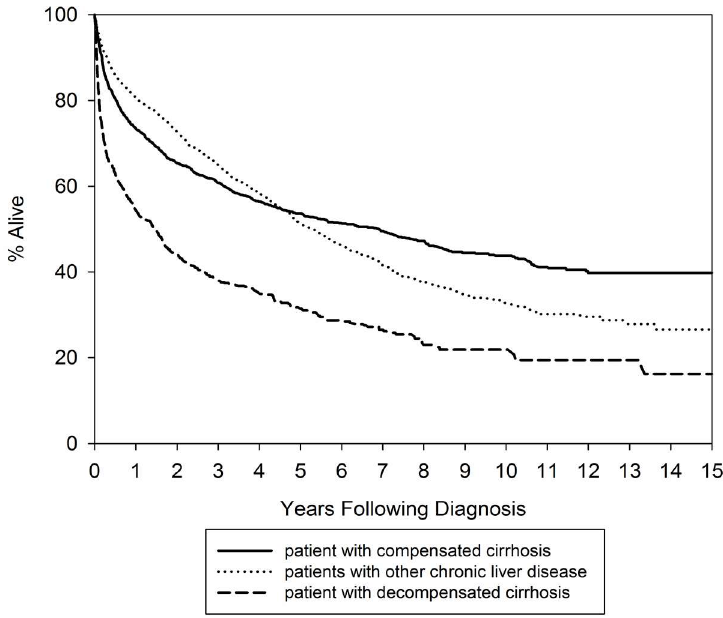
Figure 1. Kaplan-Meier survival analysis by disease stage. The log rank test for the group of compensated cirrhosis vs. the group of other chronic liver disease, p = 0.906; for the group decompensated cirrhosis vs. the group with other chronic liver disease, p < 0.001. Table 2. Health services use and mortality rate among HCC patients during the study period, by disease stage. Overall Compensated Cirrhosis Decompensated Cirrhosis Others ( n = 5522) ( n = 2007) ( n = 1392) ( n =